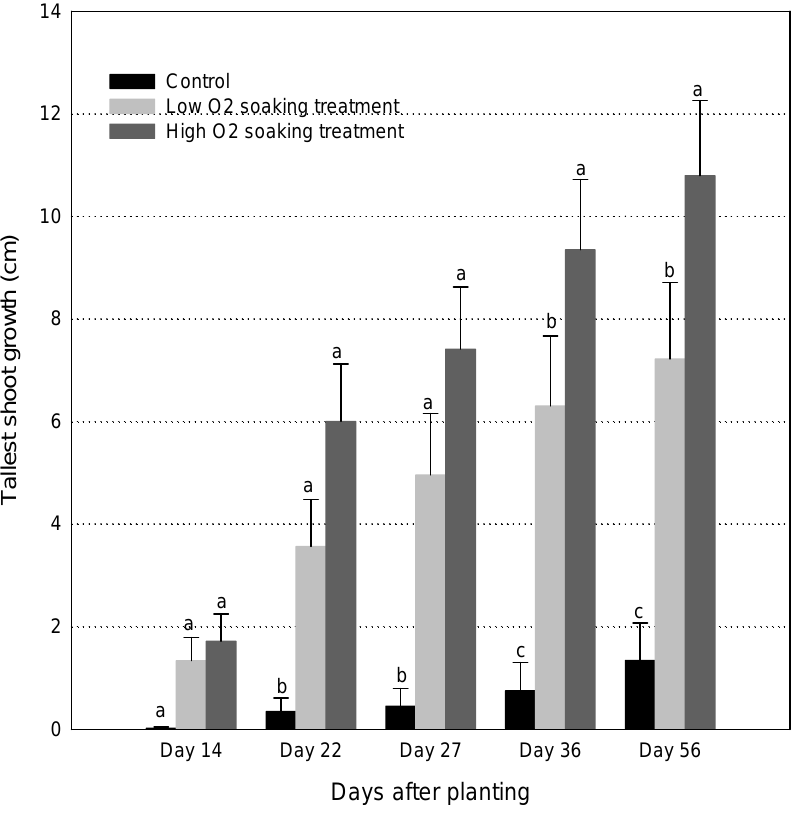
FIGURE 4 . Mean growth of tallest shoot (cm, ± s.e.) of black willow ( S. nigra ) cuttings in control, low O 2 and high O 2 soaking treatment groups for days 14, 22, 27, 36, and 56 after planting (n = 30). Different lower case letters above each bar represent significant differences between treatment groups on each day ( p ≤ 0.05).